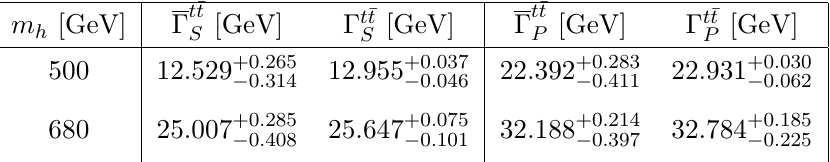
Table 1 . The t (cid:22) t decay widths at NNLO QCD, (cid:0) t Higgs boson for two Higgs-boson masses computed with the MS and on-shell top-Yukawa couplings, respectively, cf. equations (3.12) and (3.1). The reduced Yukawa couplings are chosen to be a t = 1 and b t = 1, respectively. The central values correspond to the scale (cid:22) = m h and the uncertainties to (cid:22) = m h = 2 and (cid:22) = 2 m h